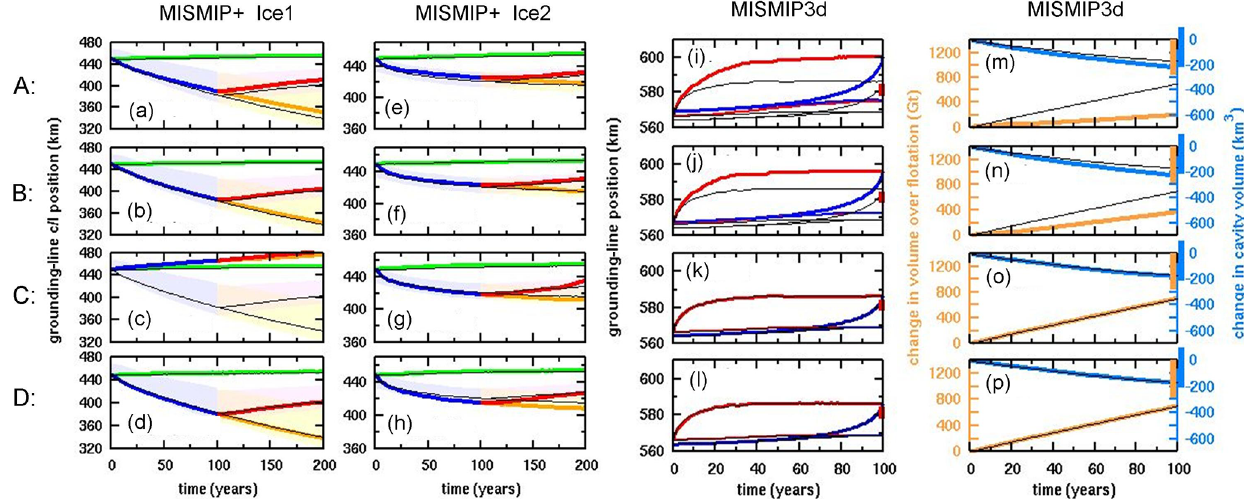
Figure A1. MISMIP + and MISMIP3d results for four alternate methods of determining buttressing factor θ . Rows (top to bottom) are for methods A to D described in the text. (a–d) MISMIP + Ice1 experiment, as in Fig. 3. (e–h) MISMIP + Ice2 experiment, as in Fig. 6. (i– l) MISMIP3d experiment, grounding-line positions as in Fig. 7a. (m–p) MISMIP3d experiment, changes in total volume over flotation and cavity volume as in Fig. 7b. Thick colored lines: as in the main paper except with one of the alternate θ methods. Thin black lines: as in the main paper with the new θ method described in Sect. 2 using Eq.